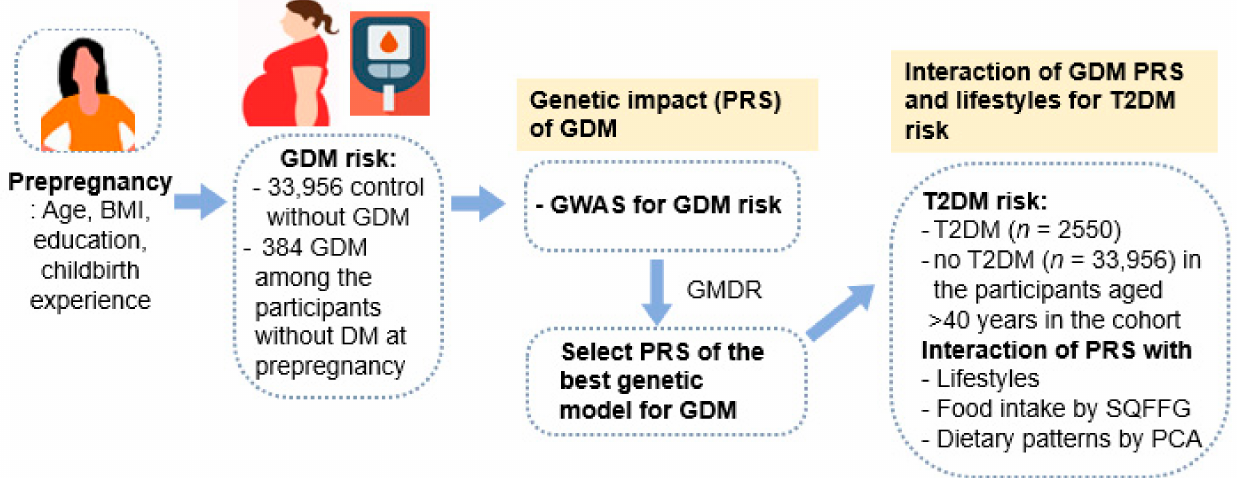
Figure 1. Research scheme of the present study. GDM, Gestational Diabetes Mellitus; GWAS, Genome-Wide Associ- ation Study; PRS, Polygenetic Risk Scores; GMDR, Generalized Multifactor Dimensionality Reduction; T2DM, Type 2 Diabetes Mellitus; DM, Diabetes Mellitus; SQFFQ, Semi-Quantitative Food Frequency Questionnaires; PAC, Principal Component